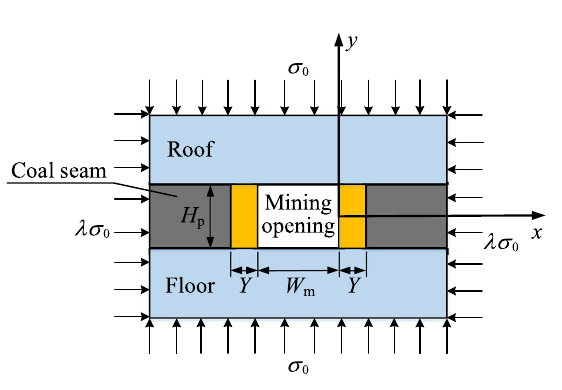
Fig. 3 Mechanical model of mining opening and surrounding rock